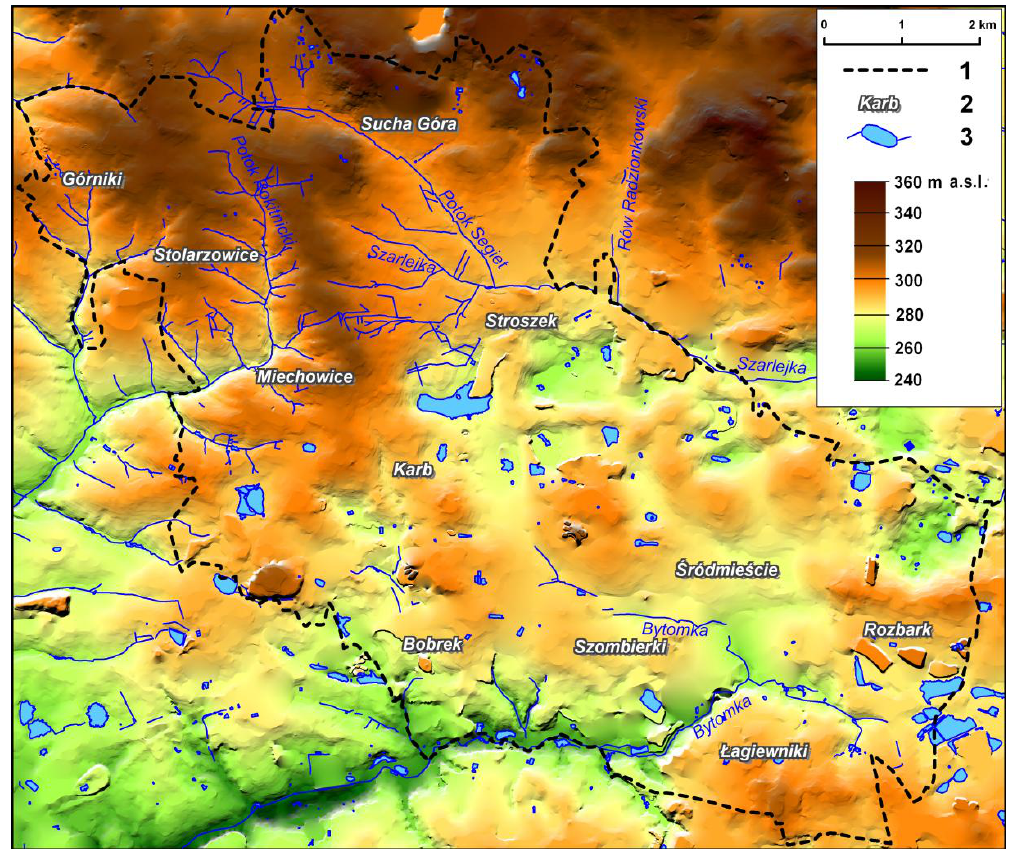
Fig. 1. Land relief of the Bytom area at the end of the 20 th century with visible subsidence zones in the central and eastern part of the city (the author’s own work) 1 – boundaries of the city, 2 – districts of city, 3 – rivers and water